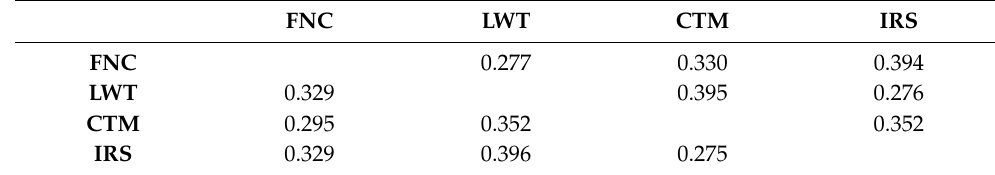
Table A11. Relation Matrix with the values of wj.